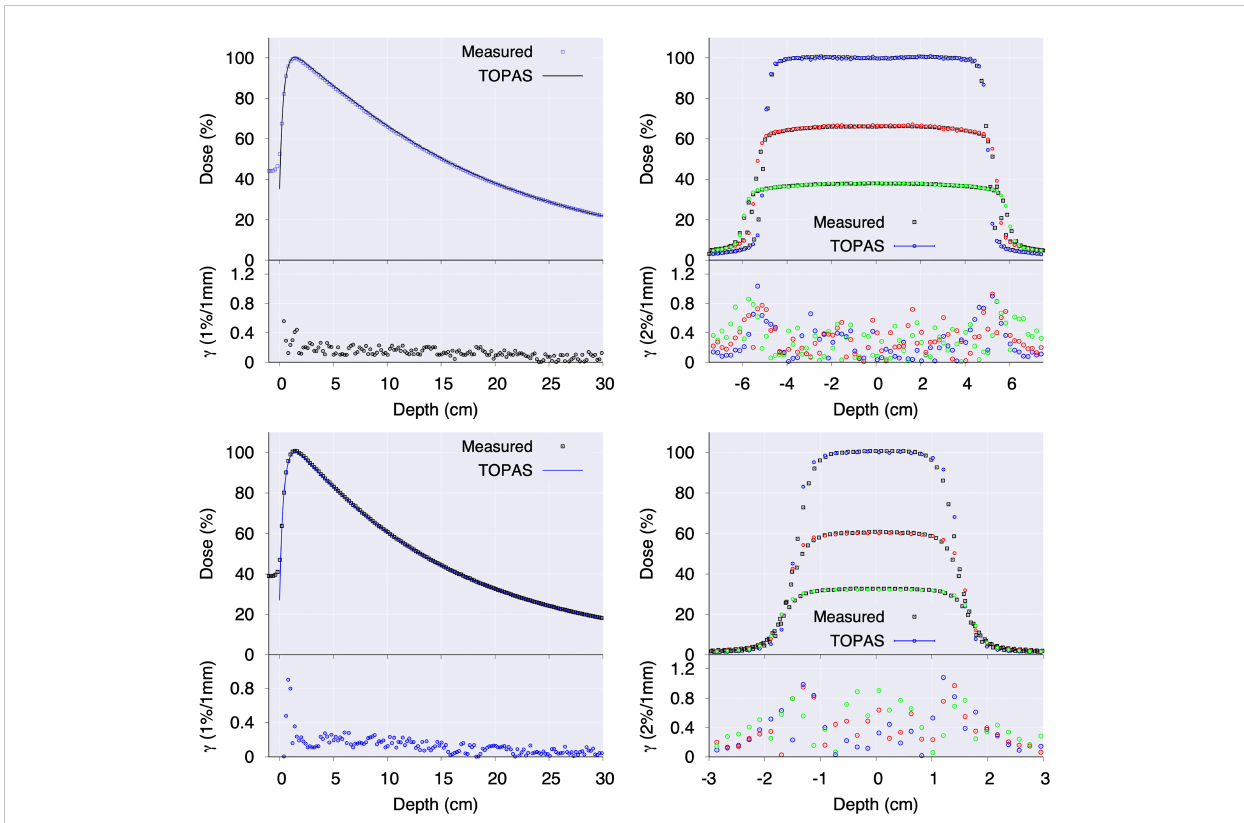
FIGURE 3 Percentage depth-dose and crossline pro fi les for 10 x 10 cm 2 (top row panel A and B) and 3 x 3 cm 2 (bottom row C , D ) fi elds calculated with Varian phase spaces. Crossline pro fi les (B, D) are presented at depth of maximum dose, and at 10 cm and 20 cm depth. The g -index values are presented at the bottom of each